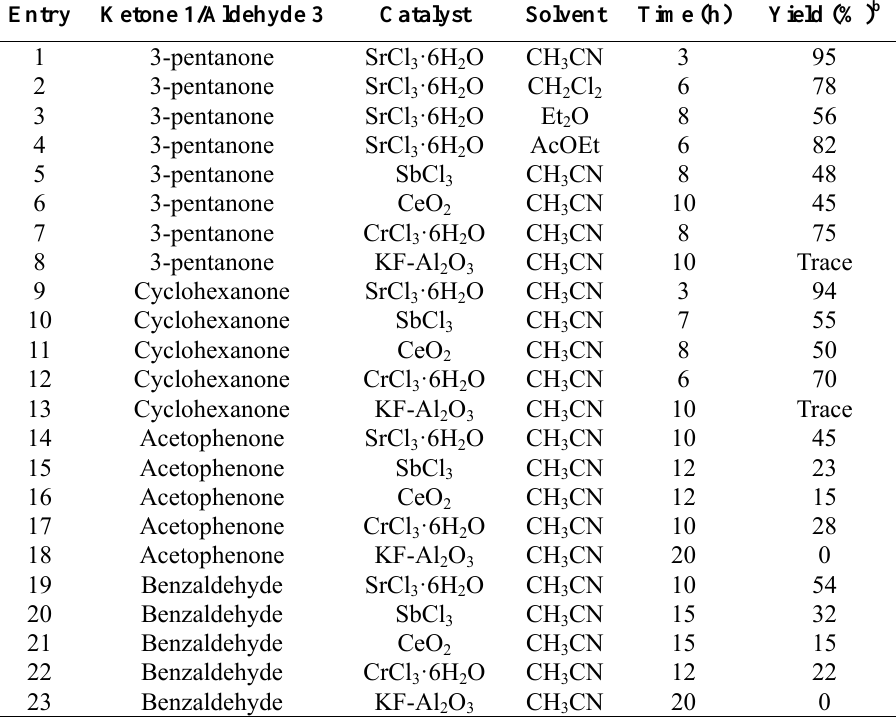
Table 1. Effects of catalyst and solvent in the synthesis of gem -DHPs. a